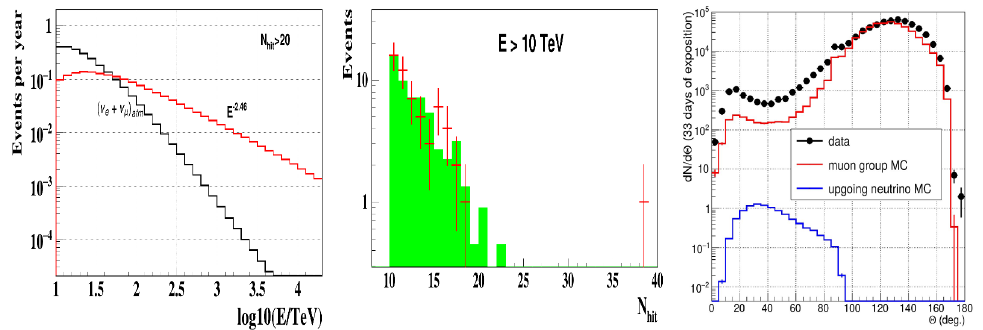
Figure 2. Left: Energy distributions of events expected for one year observation from astrophysical fluxes with E − 2 . 46 spectra and IceCube normalization, and from atmospheric neutrinos. Centre: Measured distribution of hit OMs multiplicity in cascade-like events with energies above 10 TeV and expected one from atmospheric muons (green histogram). Right: Zenith angle distribuitions reconstructed with data samlpe of muon-like events (dots) and with MC atmospheric muons (red) and neutrinos